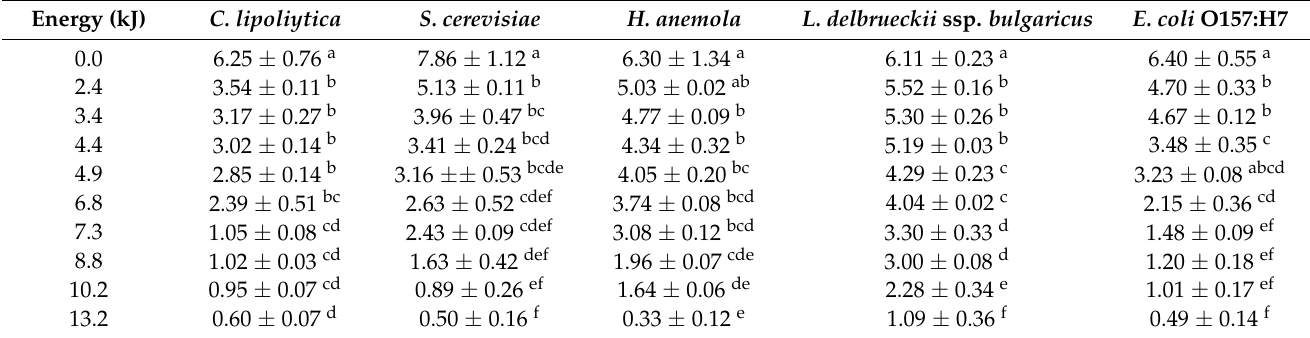
Table 2. Inactivation of yeasts and bacteria in red wine samples treated by pulsed electric